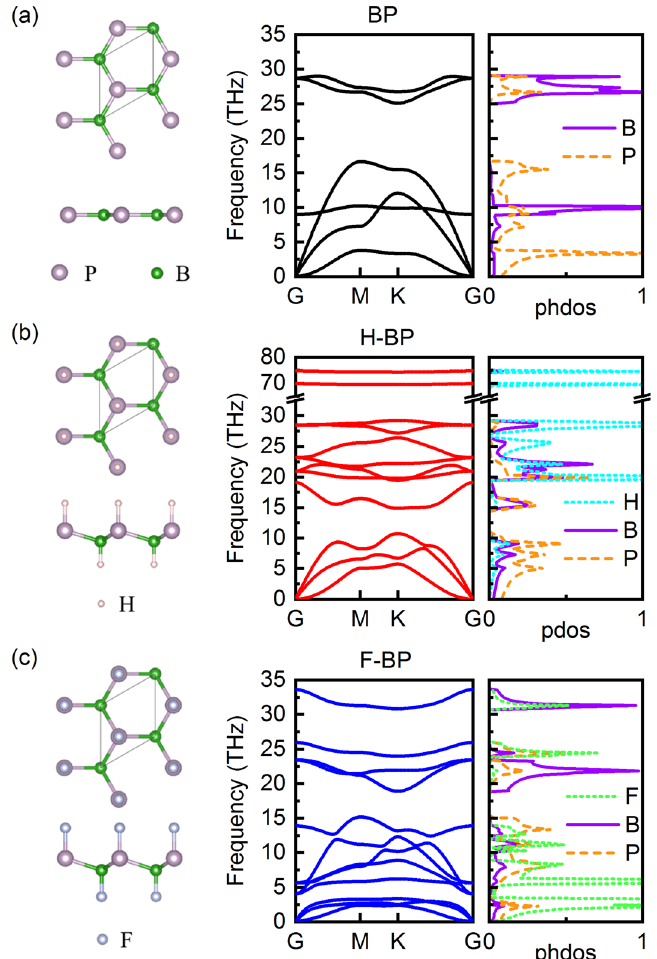
Figure 1. Top view and side view for ( a ) BP, ( b ) H-BP and ( c ) F-BP with corresponding phonon dispersions and density of